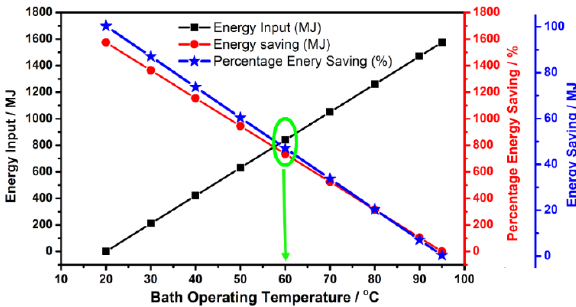
Figure 8. Energy considerations based on changing operating temperature of a 5000 liter sealing bath operating at 95 °C with an ambient temperature of 20 °C (specific heat capacity of water ≈ 4200 J/kg operating at 95 ◦ C with an ambient temperature of 20 ◦ C (specific heat capacity of water ≈ 4200 J / kg ◦ °C)).